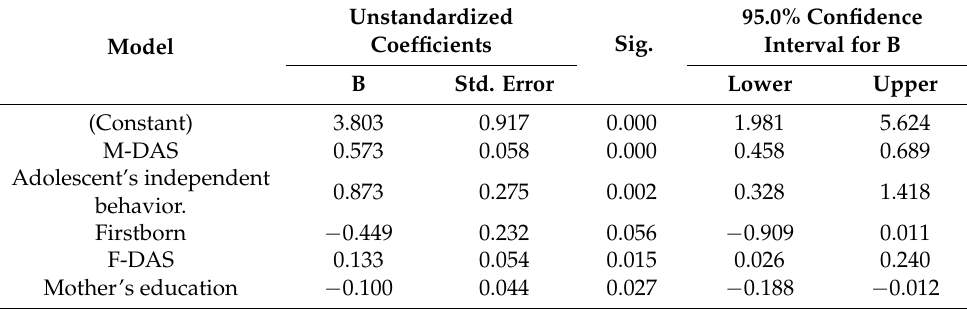
Table 3. Variables predicting adolescent’s dental